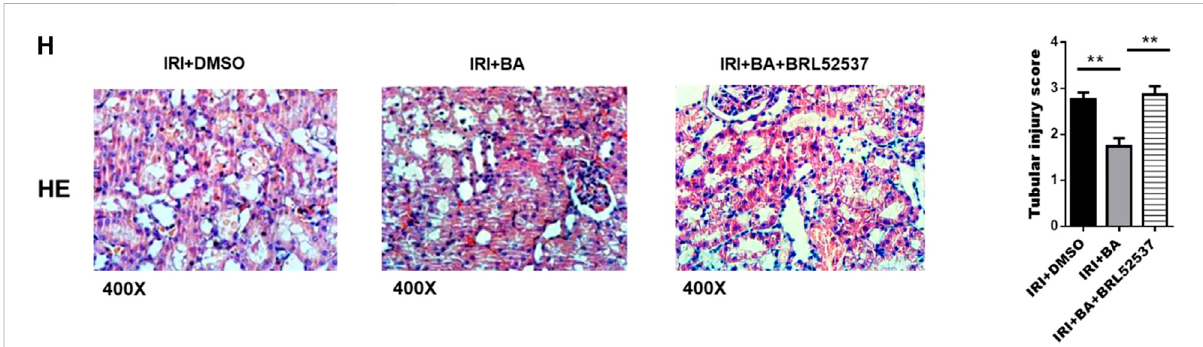
FIGURE 4 BA protects against renal IRI via p-STAT3/SOCS3 signaling. (A,B) BA treatments attenuated the expression of p-STAT3 but not p-JAK2. (C,D) AfterBRL52537treatment,theexpressionofp-STAT3butnotp-JAK2 wasincreased. (E – G) BRL52537signi fi cantlyattenuatedtheanti-in fl ammatory effects of BA on renal IRI. (H) HE staining indicated that BRL52537 signi fi cantly attenuatedthe protective effects of BA on renal IRI. Sample size = 3in each group. Data were presented as mean ± standard deviation. N.S. p > 0.05, * p < 0.05, ** p <